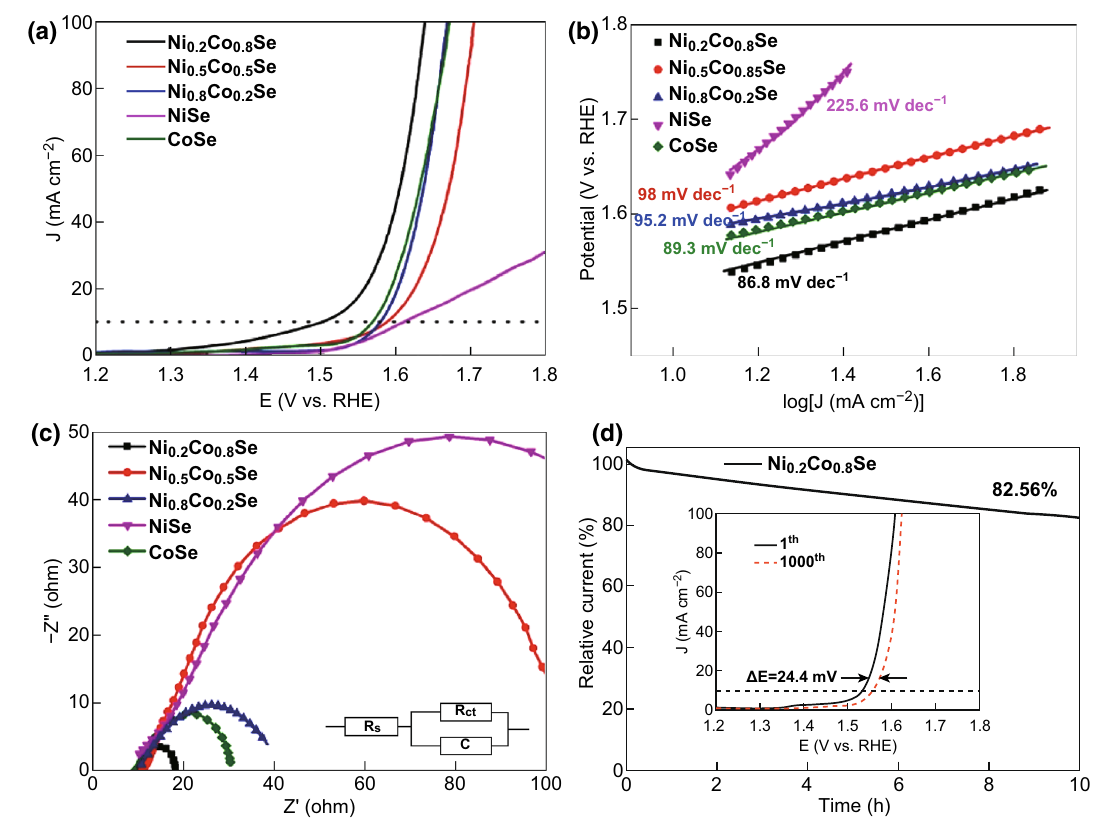
Fig. 4 a IR‑corrected LSV curves of Ni 0.2 Co 0.8 Se, Ni 0.5 Co 0.5 Se, Ni 0.8 Co 0.2 Se, NiSe, and CoSe in an N 2 ‑saturated 1 M KOH solution obtained at a scan rate of 10 mV s −1 . b Tafel plots of the Ni 0.2 Co 0.8 Se, Ni 0.5 Co 0.5 Se, Ni 0.8 Co 0.2 Se, NiSe, and CoSe catalysts for the OER in 1.0 M KOH. c EIS Nyquist plots, where Rs represents the electrolyte resistance, C represents the double‑layer capacitance, and R ct represents the charge‑trans‑ fer resistance. d Chronoamperometric response of Ni 0.2 Co 0.8 Se nanocages. The inset shows the LSV curves of an Ni 0.2 Co 0.8 Se electrode tested after 1 and 1000 CV